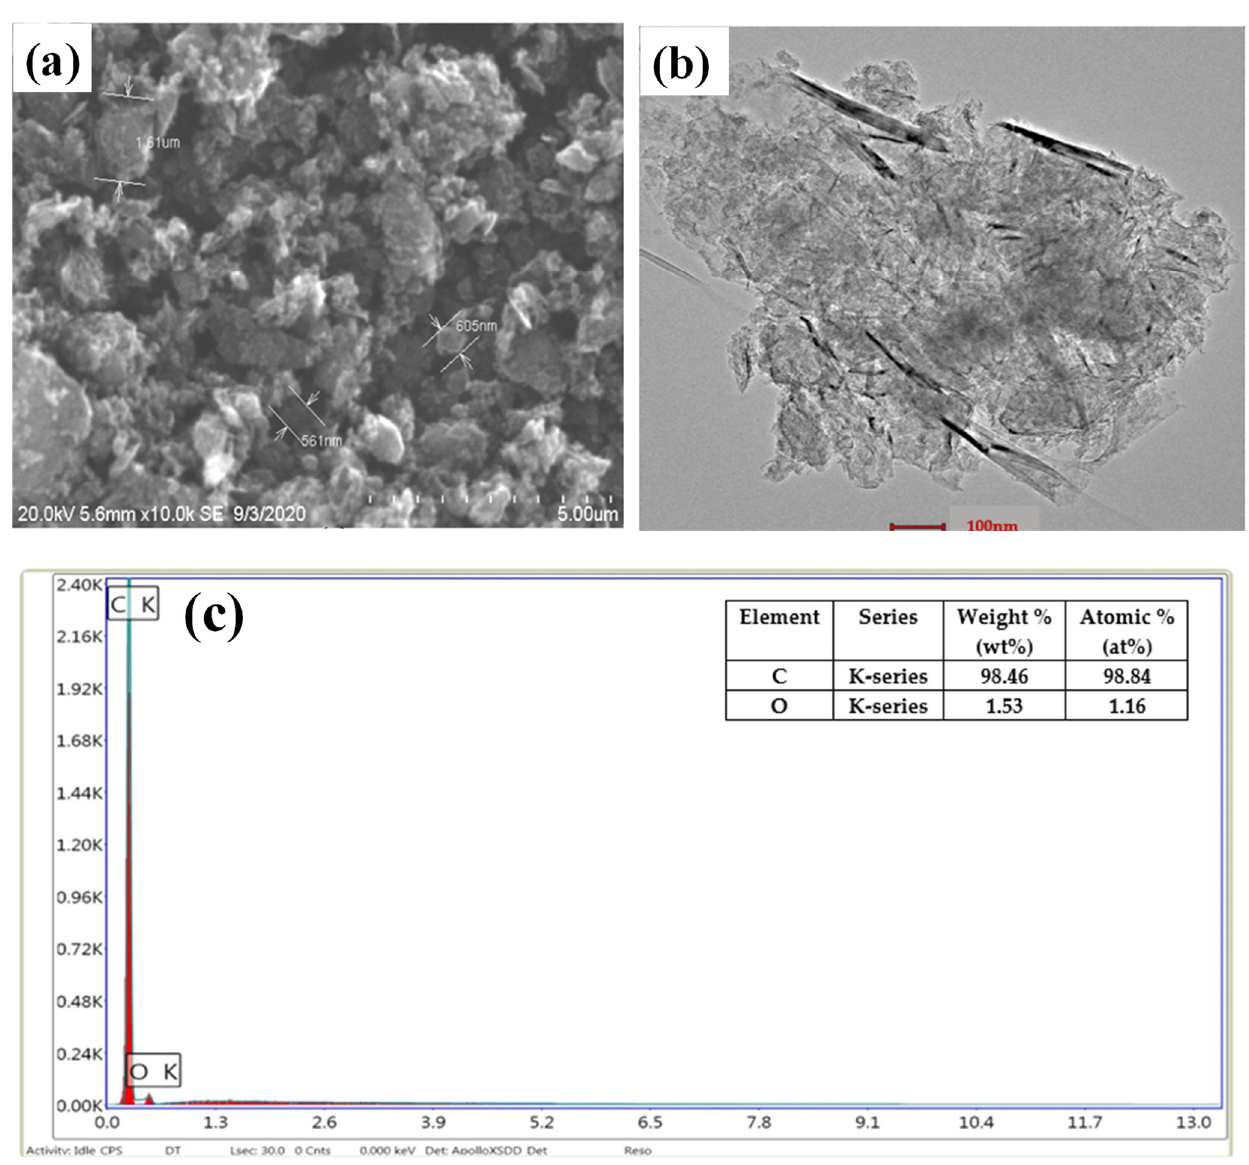
Figure 1. Morphology and element composition of GNPs: ( a ) SEM micrograph, ( b ) HRTEM micrograph, and ( c ) EDS analysis. Table 3. Properties of graphene nanoplatelets.